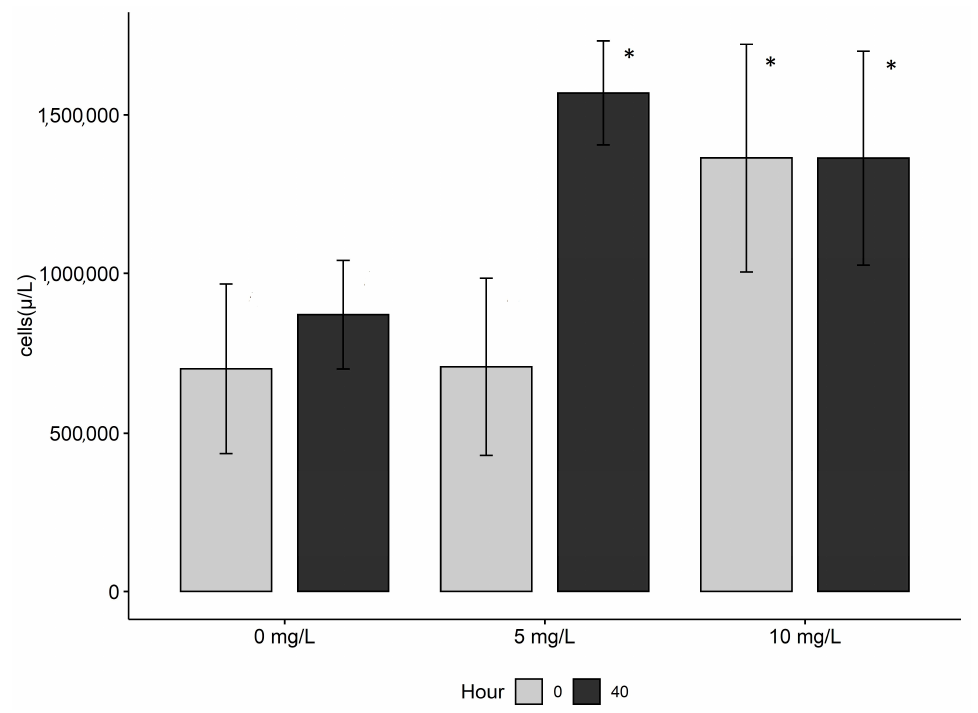
Figure 1. Bacterial cell concentrations (cells/ µ L) for the 3 DOC addition treatments 0 mg/L, 5 mg/L, and 10 mg/L in the Artemia on-growing chambers during the bio-encapsulation period. 0 h measurements were taken minutes after the addition of leachate and Artemia to freshly prepared on-growing tanks. 40 h measurements were taken from pre-prepared on-growing tanks to be used for feeding that day, approximately 40 h after the addition of leachate and Artemia. Error bars represent standard error of the mean (n = 9), and asterisks (*) denote statistical differences.